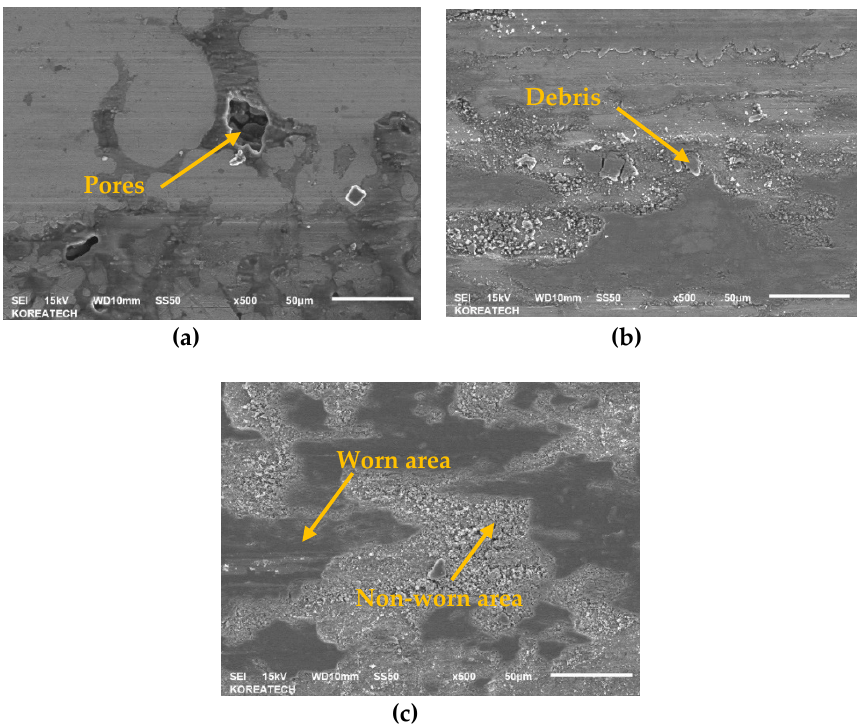
Figure 13. High-magnification SEM images of the wear track formed on the surface of the as-PM ( a ), UNSM-25 ( b ) and UNSM-300 ( c ) samples.